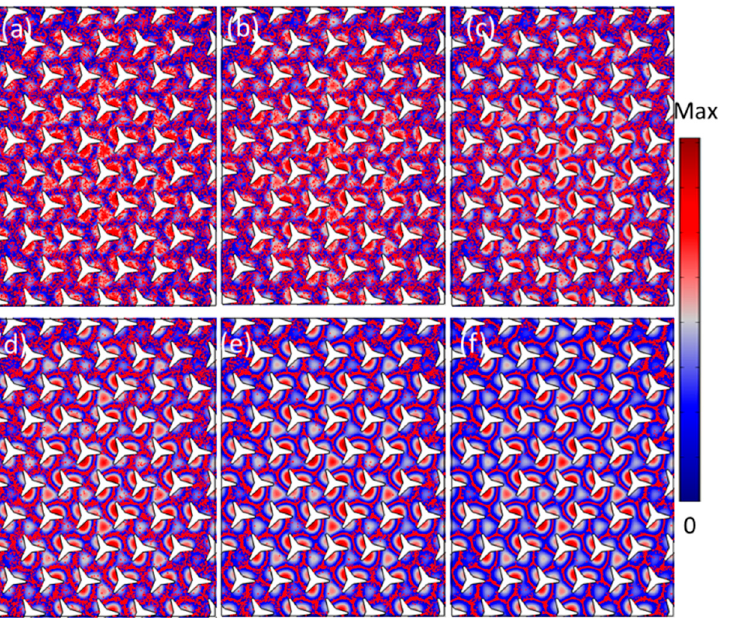
Figure 4. Numerical validation of the microparticles patterning and locations for the case of the incident wave at the frequency of 167.6 kHz. ( a – f ) The microparticles distribution at the stating positions when t = 0 s, t = 1 s t = 2 s t = 3 s t = 5 s, and t = 8